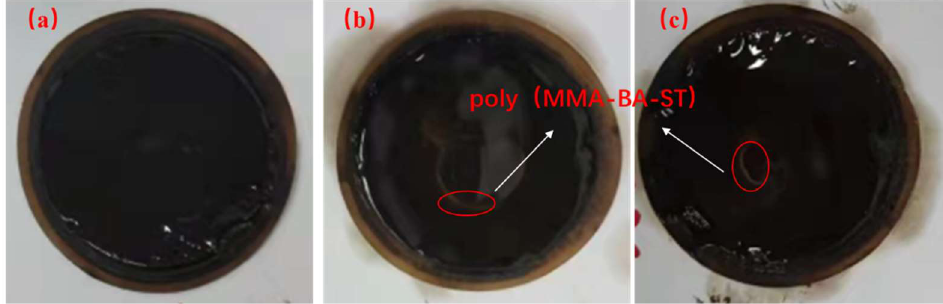
Figure 10. Mud cake samples before and after the addition of poly (MMA-BA-ST), ( a ) no addition, ( b ) 0.5% addition, ( c ) 1.0% addition.